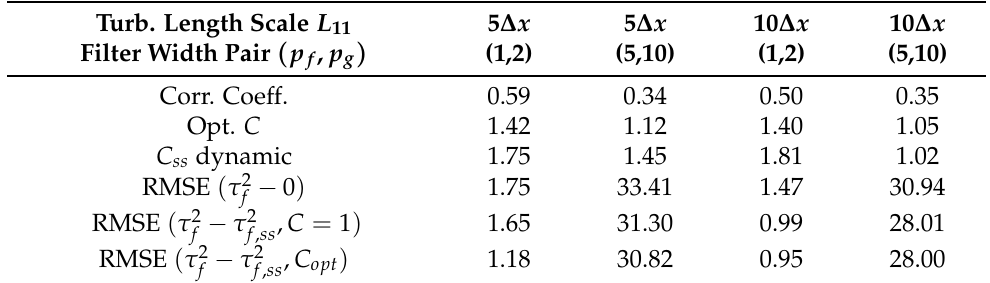
Table 2. Performance of model τ 2 for different initial data and different filter sizes (note that f , ss the correlation coefficient is independent of the secondary filter). Dynamically determined model coefficient C for different initial data and different f , g filter size pairs ( p f , p g )